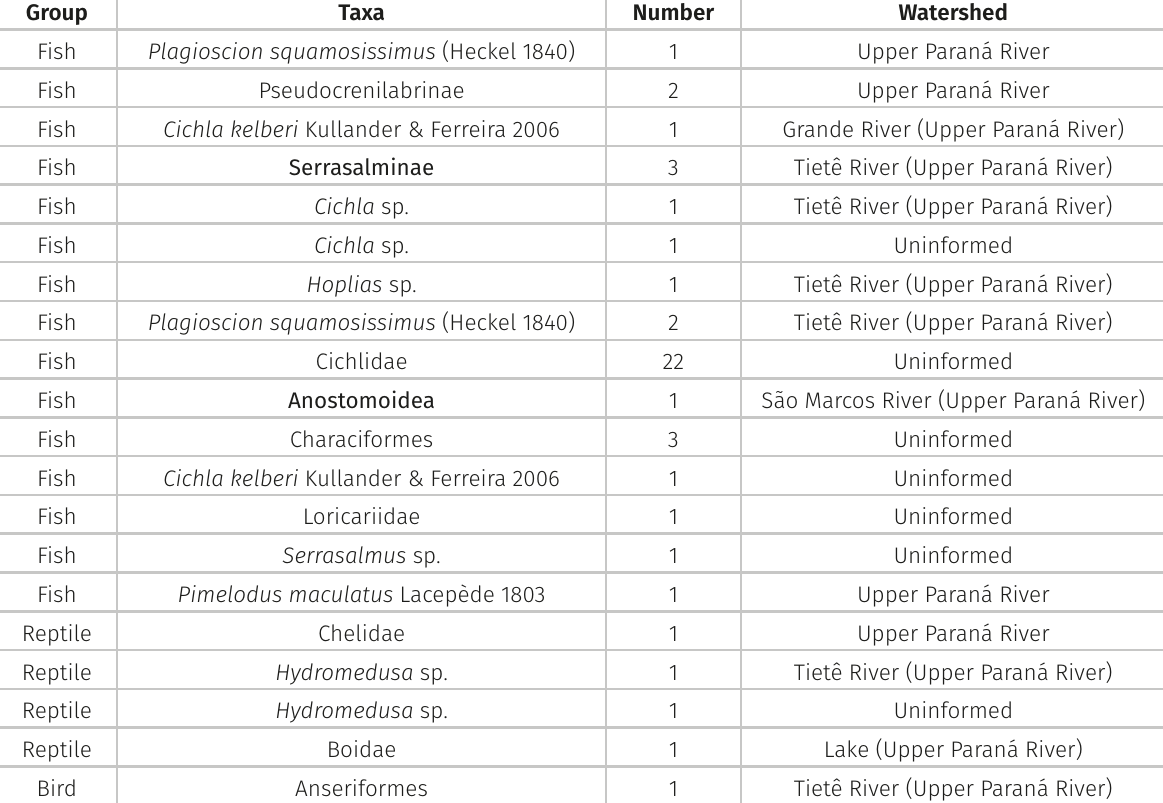
Table I. Animal taxa found in ghost nets in Brazilian freshwater ecosystems (based on results in Supplementary